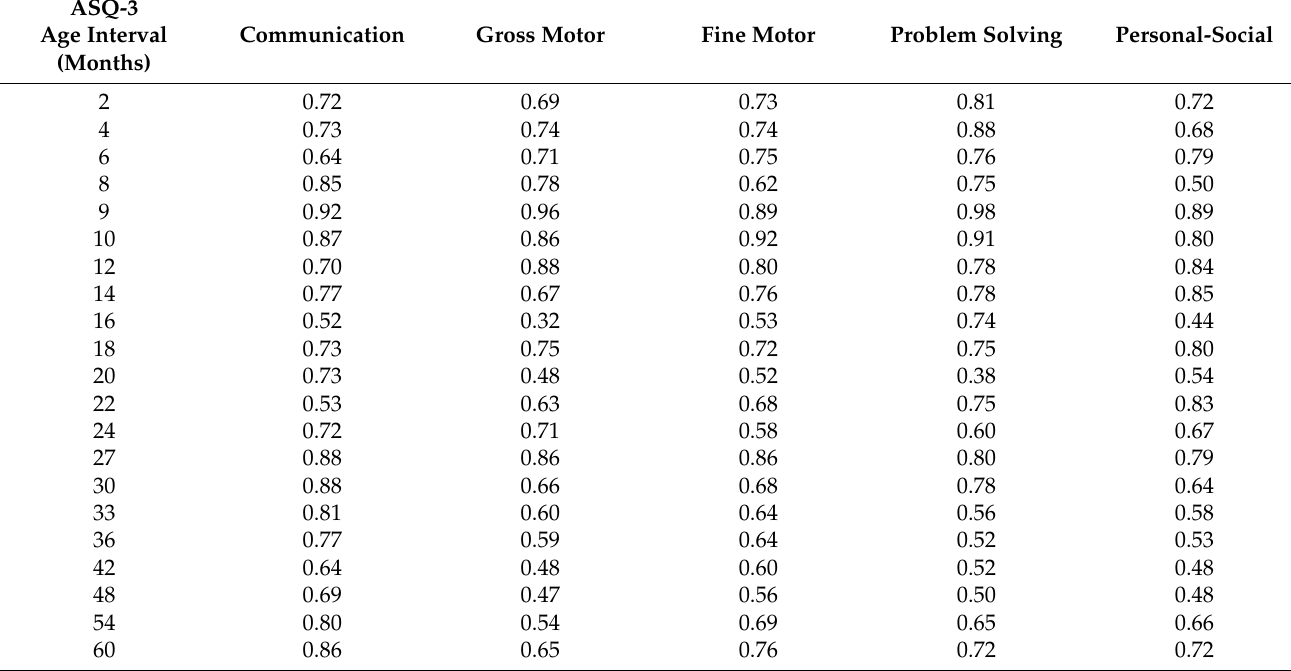
Table 2. Corrected item-total correlations of ASQ-3 developmental